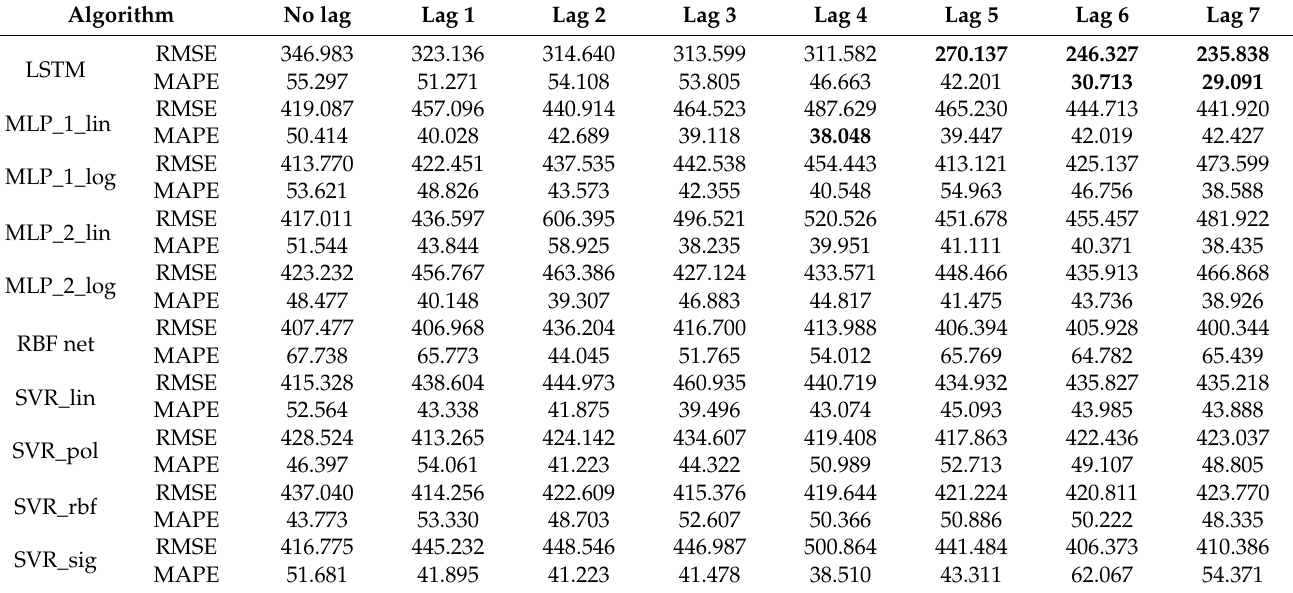
Table 5. Results of 80 combined models for Route 1 on week